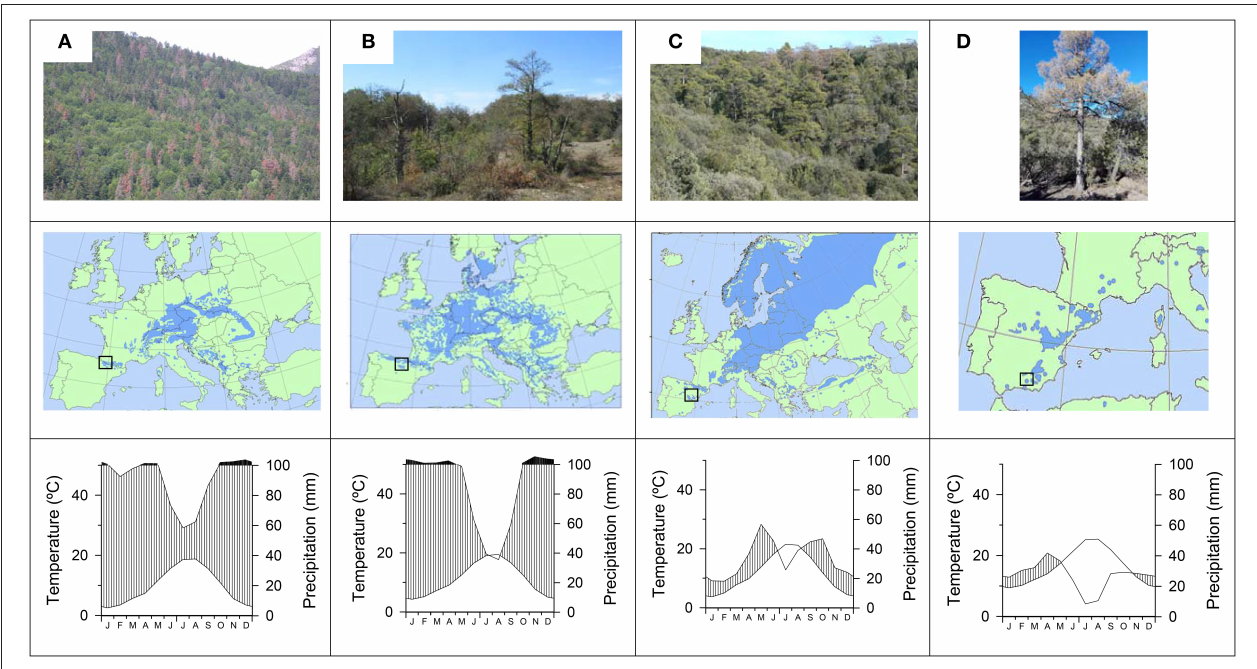
FIGURE 1 | Views, location of study sites within the European distribution area (boxes in the maps), and climate diagrams for the four study tree species showing recent drought-triggered dieback: (A) , silver fir; (B) beech, (C) Scots pine; and (D) black